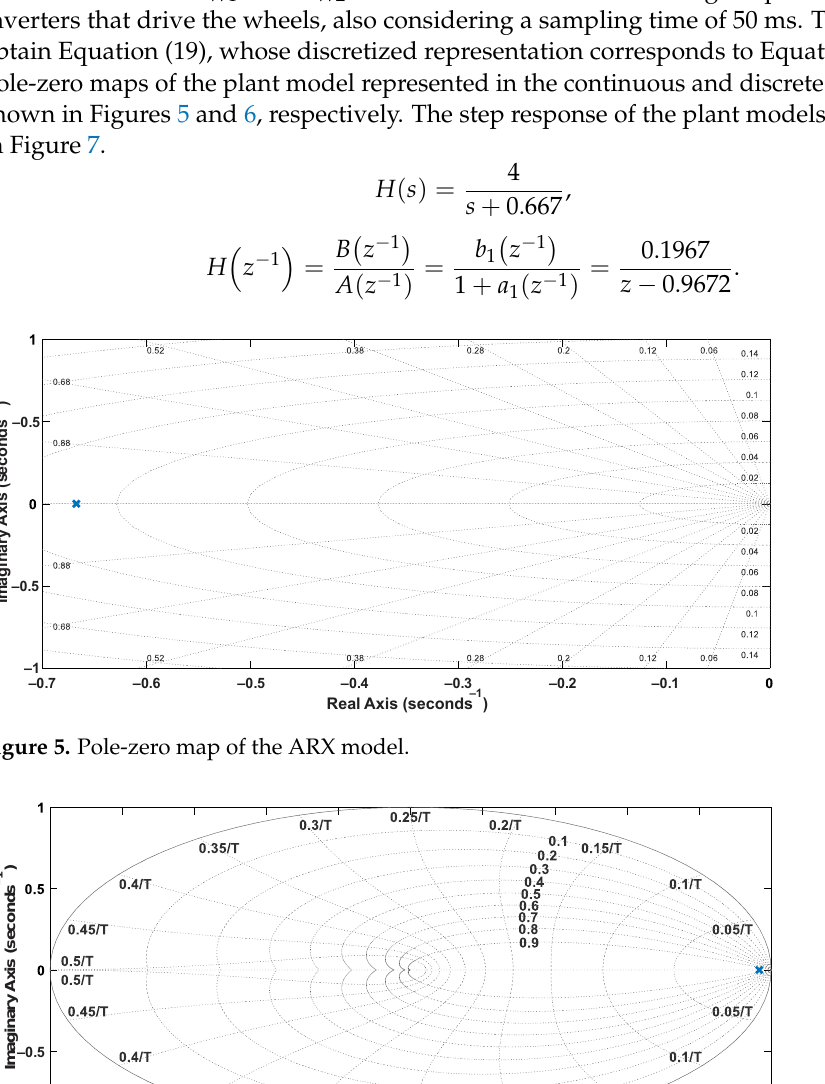
Figure 6. Pole-zero map of the discretized model.